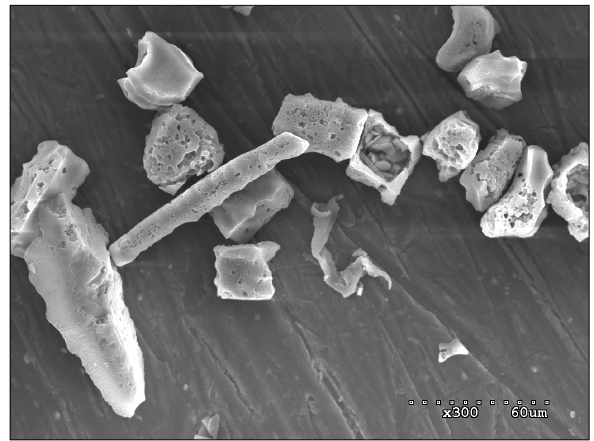
Fig. 3. Phytolith concentrate extracted at CEREGE from the Mas- Figure 3: Phytolith concentrate extracted at CEREGE from the Mascareignite level (10–20 cm) of a careignite level (10–20cm) of volcanoclastic soils from La Re- volcanoclastic soils from La Reunion, France (Crespin et al. 2008). The SEM image is used here to union, France (Crespin et al., 2008). The SEM image is used here show typical rough phytolith surfaces. to show typical rough phytolith